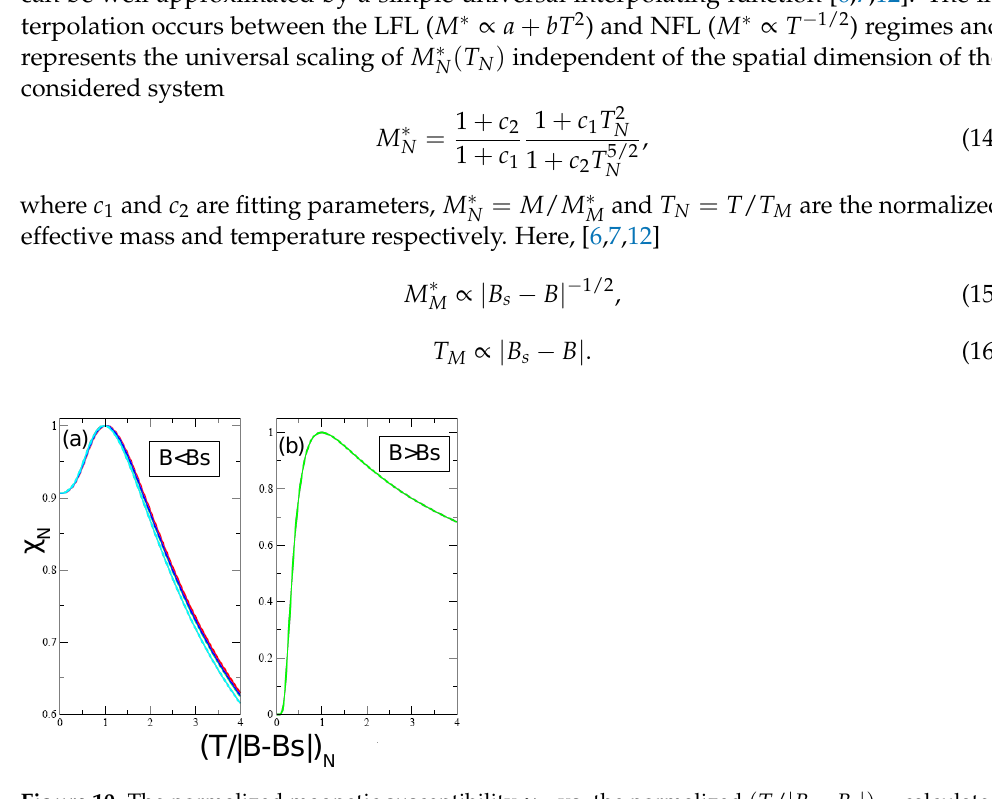
Figure 10. The normalized magnetic susceptibility χ N vs. the normalized ( T / from Equations (12) and (13) for B < B s (panel ( a )) and B > B s (panel ( b )). At B > B s the complete spin polarization occurs and χ vanish at ( T / B ) N an excellent scaling of χ N ( T / B ) N . As seen from panel ( a ), the LFL behavior holds for the weakly interacting quasi-1D quantum spin liquid [22].